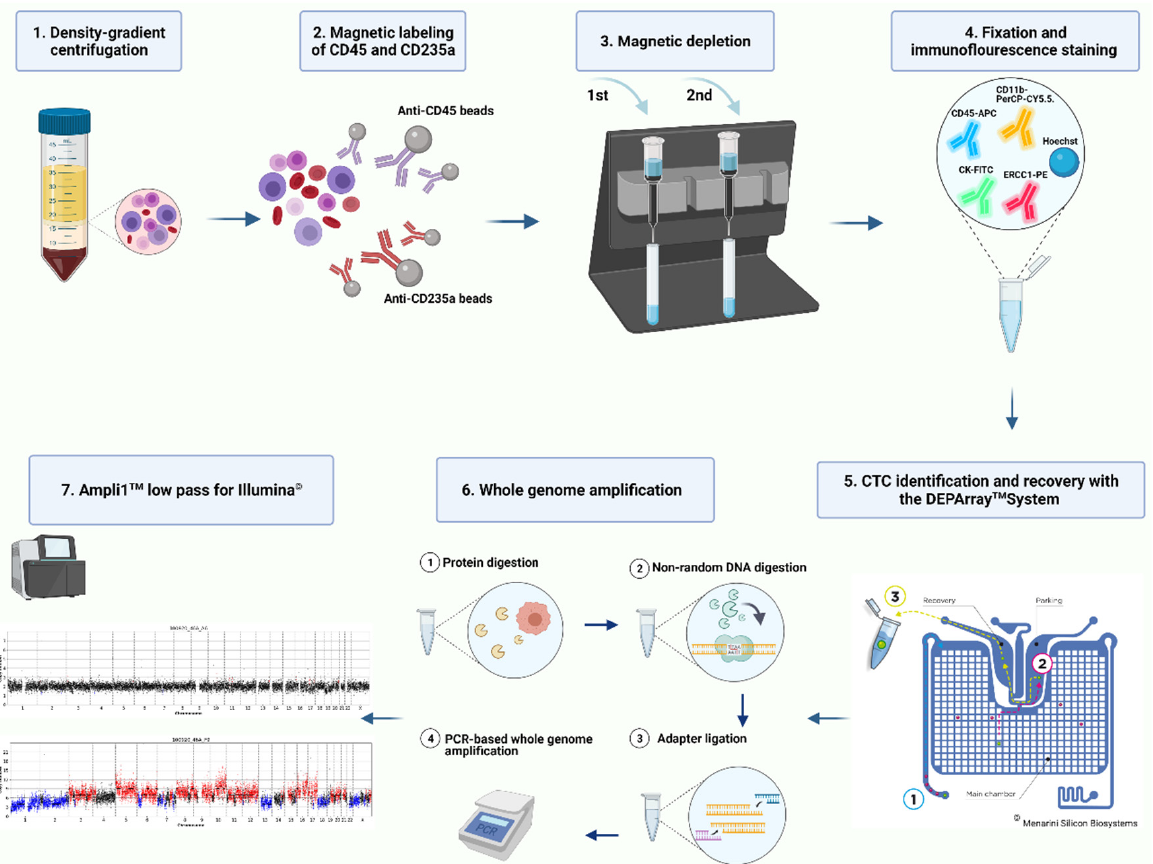
Figure 1. Workflow for single CTC isolation and molecular characterization in blood samples of HGSOC patients. After density-gradient centrifugation and magnetic-based negative depletion of erythrocytes (CD235a) and leucocytes (CD45), immunofluorescence staining was performed. Subsequent single cell imaging and sorting using the DEPArray TM Nxt was followed by a whole genome amplification. After Ampli1 TM low pass (Menarini Silicon Biosystems) library preparation, copy number variation sequencing was performed. Figure was created with BioRender.com.